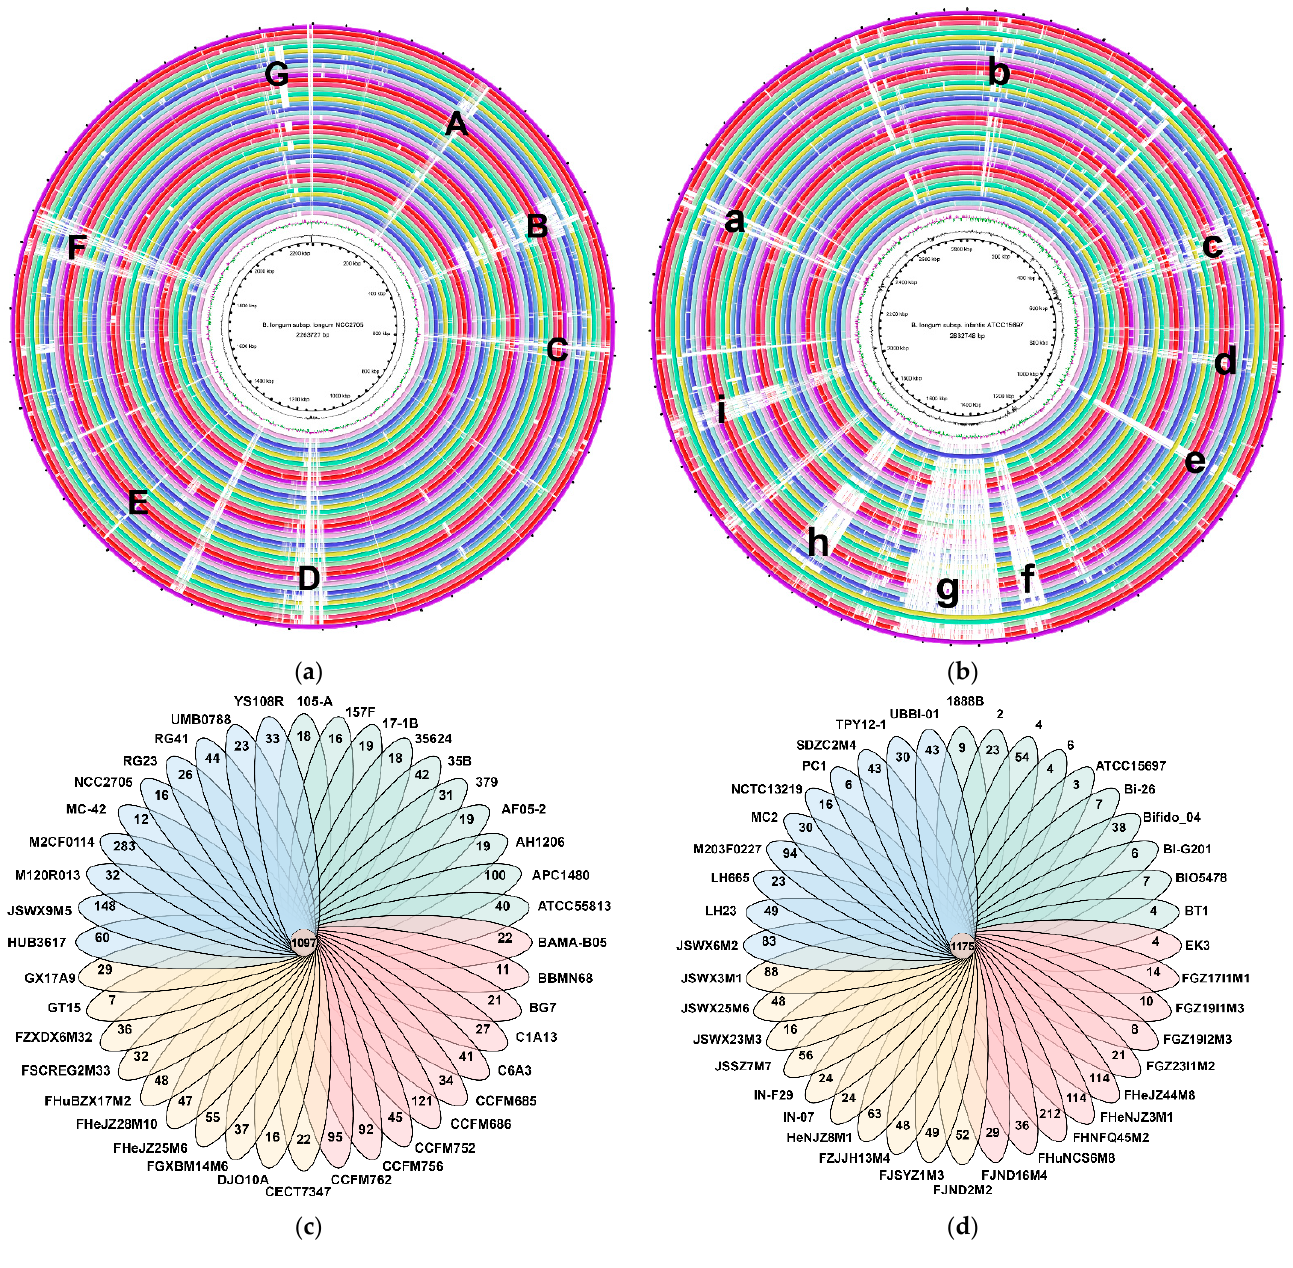
Figure 4. Comparative analysis of B. longum subsp. longum and B. longum subsp. infantis genomes: Whole genome sequence comparison of B. longum subsp. longum ( a ) and B. longum subsp. infantis ( b ). The blank areas in the figure represent genes that existed in the reference genome but not in other genomes. Orthologous genes and unique genes of B. longum subsp. longum ( c ) and B. longum subsp. infantis ( d